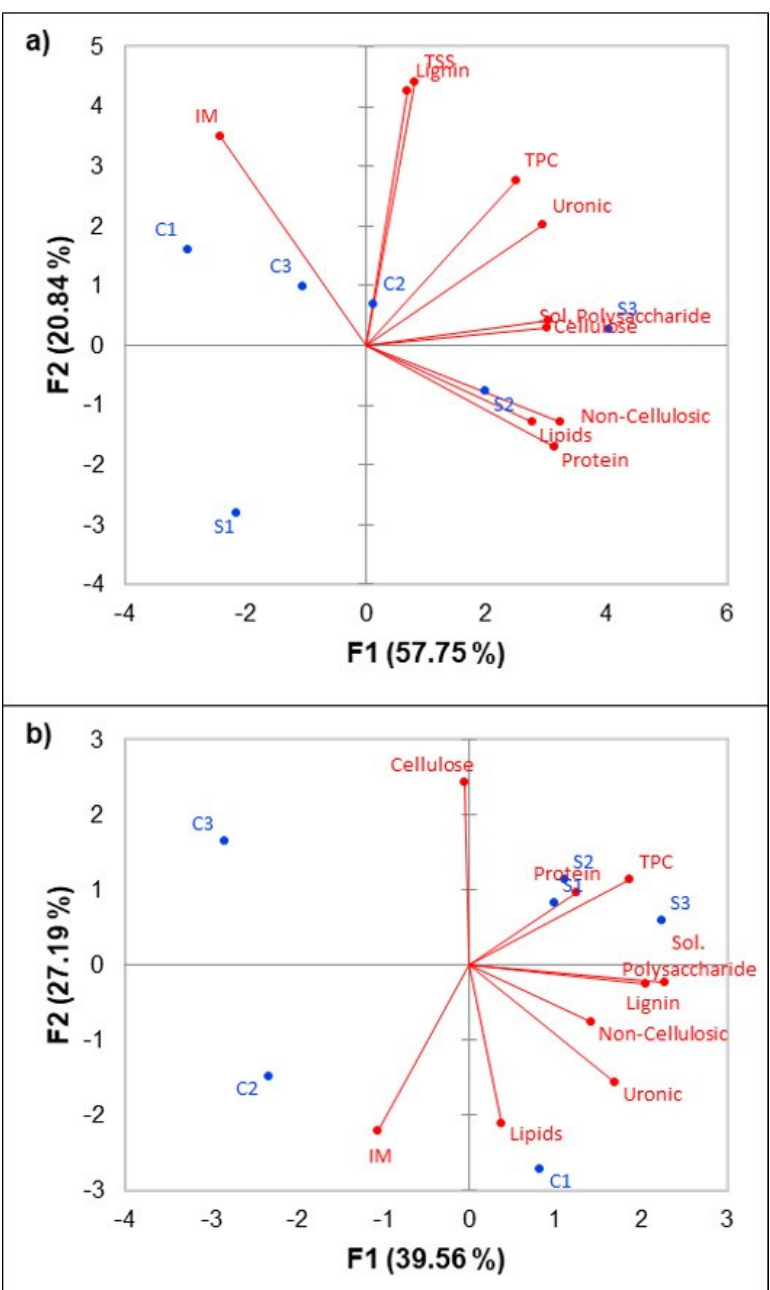
Figure 3. PCA biplot of CWM composition. ( a ) Grape skin, ( b ) Pomace skin. S-Sonoma County, C-Central Coast. Numbers 1, 2, 3 indicate different sites within the same region. IM-Isolated Material, TSS-Total Soluble Sugars, TPC-Total Polyphenolic Content.